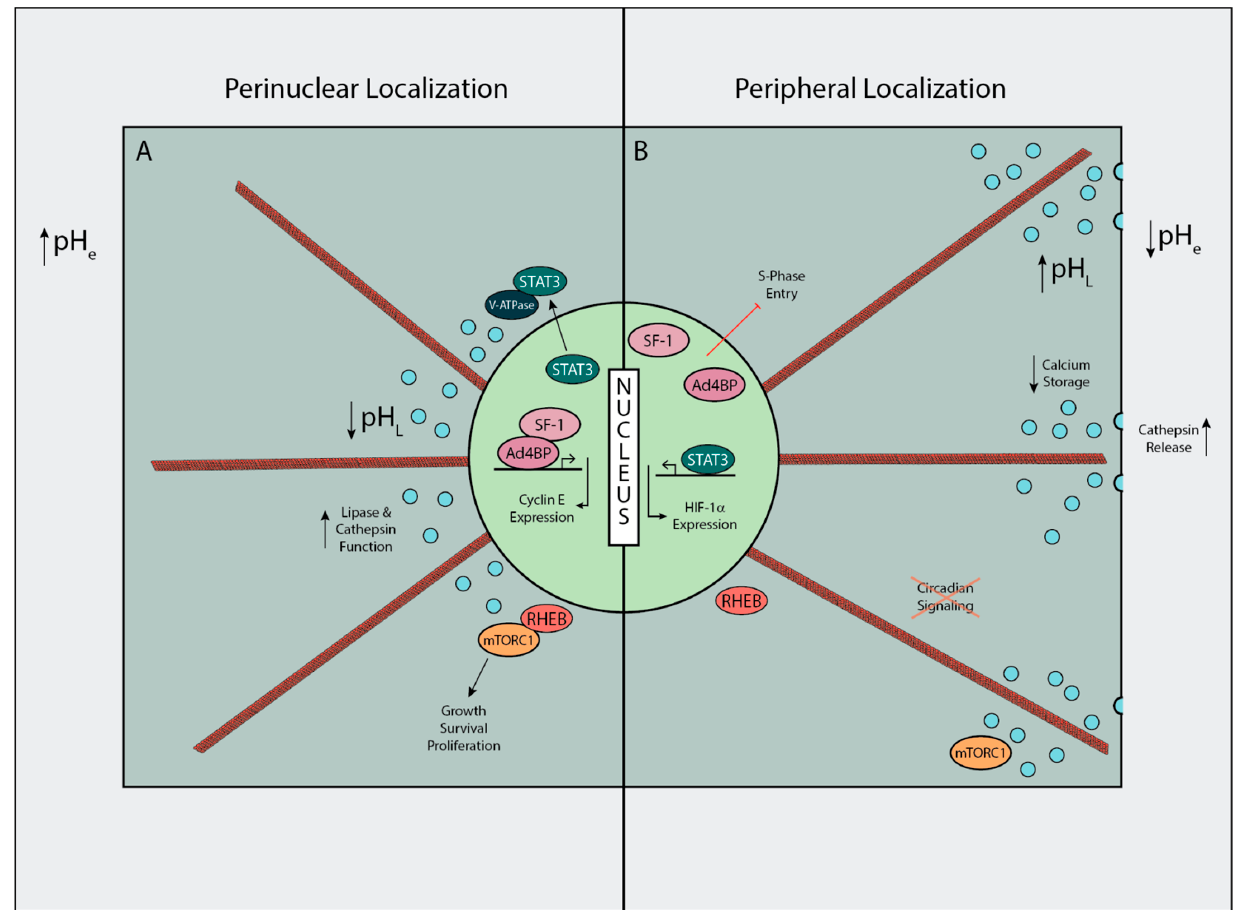
Figure 2. Lysosomal Localization and its’ Effects on Cellular Processes. ( A ) Signaling cascades and phenotype associated with a perinuclear lysosomal localization. ( B ) Signaling cascades and phenotypes associated with a peripheral lysosomal distribution. Dark grey—Cell body, Light blue—Lysosomes, Orange—Microtubules.